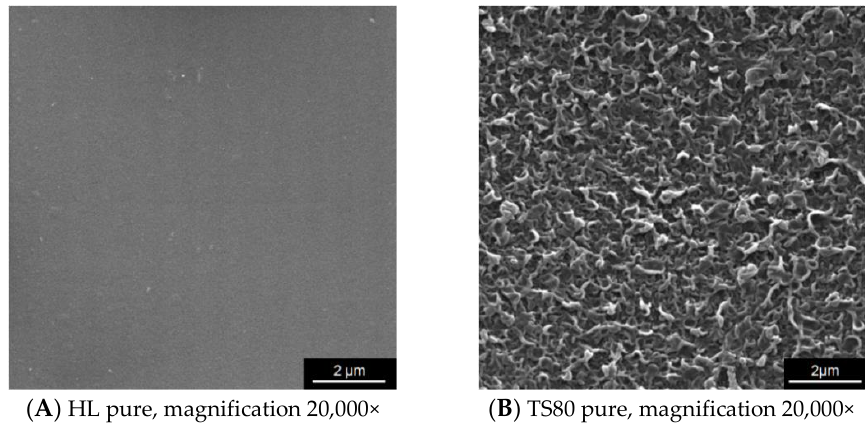
Figure 7. SEM microscopic images of selected membranes at 20,000×: ( A ) HL pure, magnification 20,000×; ( B ) TS80 pure, magnification 20,000×. Figure 6. Dependence of filtrate flux on the filtration time: ( A ) for HL membrane; ( B ) for TS80 membrane; pressure 1.0 MPa, temperature 30 °C.